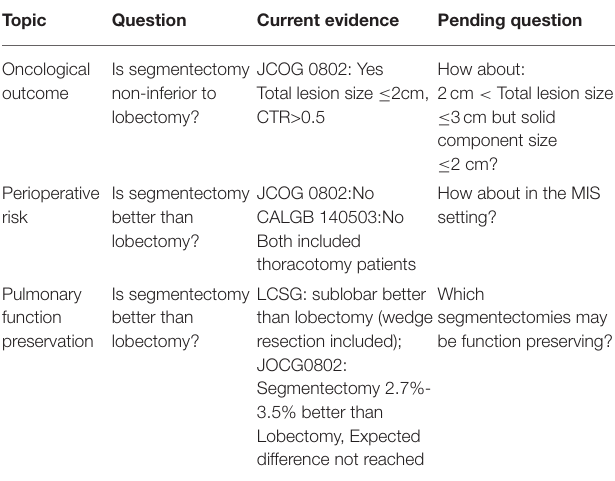
TABLE 1 | Current evidence and unsolved questions on segmentectomy for ground glass opacity (GGO)-containing early-stage lung